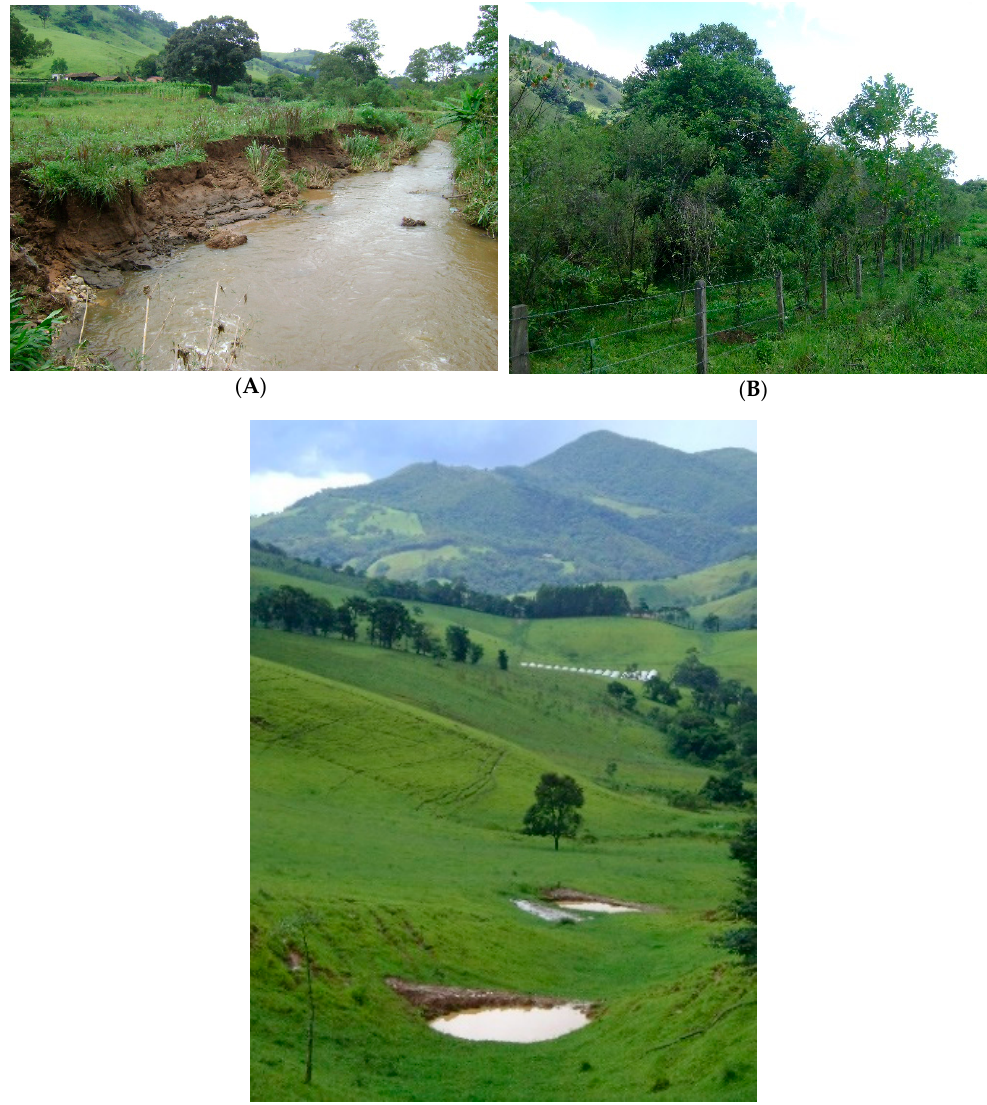
Figure 2. Images from the Water Producer Project, in the Piracicaba, Capivari, and Jundiai watershed, Atlantic Forest, Brazil: ( A ) degraded riparian area; ( B ) native tree seedlings planted for forest restoration; ( C ) infiltration holes to reduce rainwater runoff.